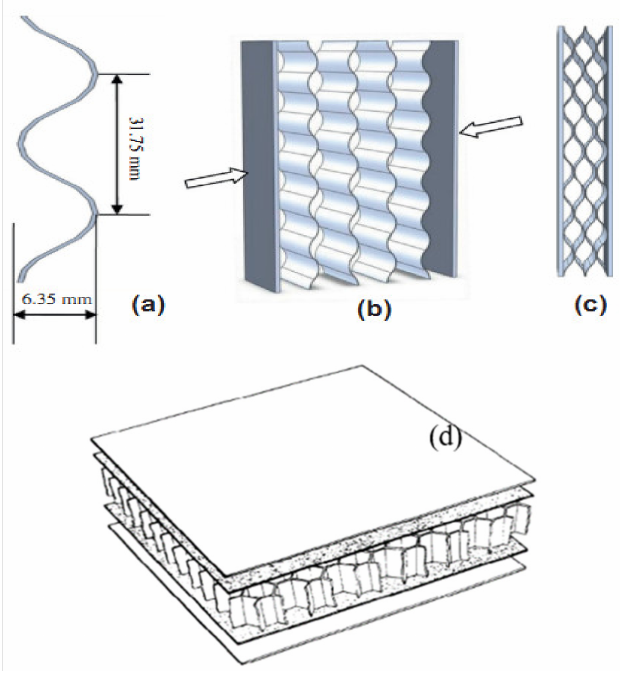
Figure 5. ( a ) Corrugated core sheet dimension; ( b ) Assembly procedure [31]; ( c ) Final sandwich panel; ( d ) Honeycomb sandwich structure